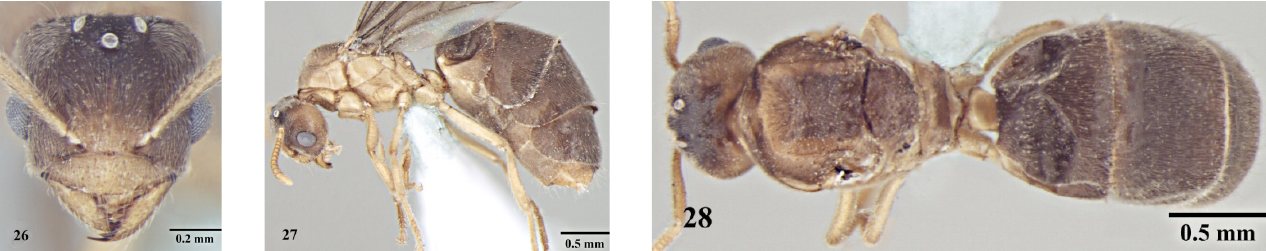
Fig. 26-28 . Pseudolasius polymorphicus sp. n ., gyne 26) head, full face view; 27) body, lateral view; 28) body, dorsal